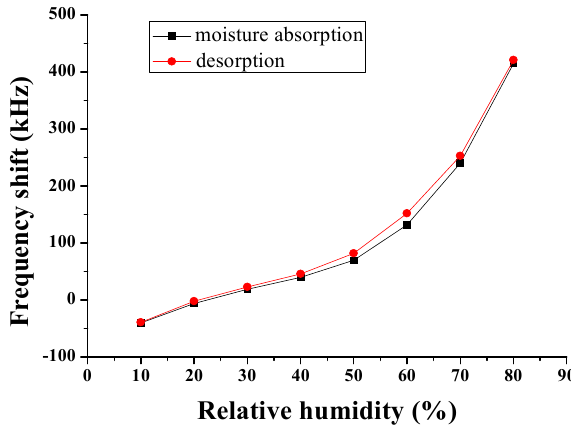
Figure 11. Hysteresis characteristics of the Love wave humidity sensor.